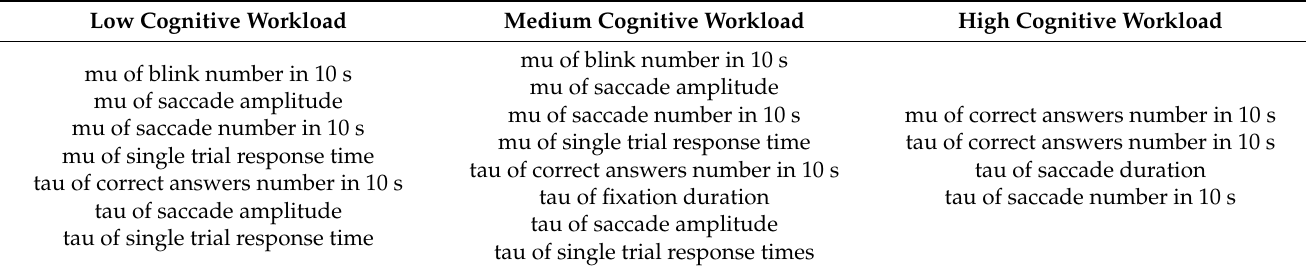
Table 2. The features belonging to the clusters of high and medium importance according to linear SVM model, presented separately for each cognitive workload